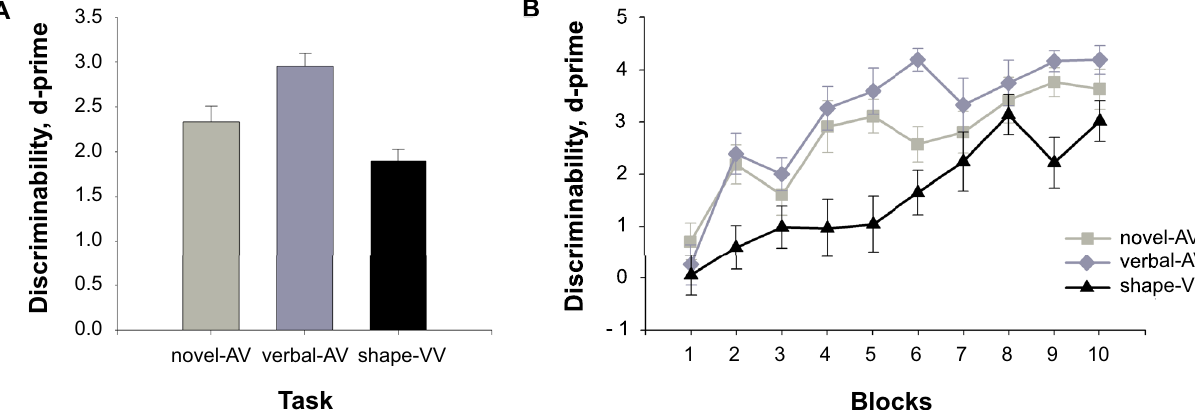
Figure 4. Discriminability measures for associative learning tasks. A . Overall mean discriminability (d-prime) (± SEM) for the novel-sound auditory-visual (novel-AV), the verbal-visual (verbal-AV), and the visual-visual with red shapes (shape-VV) learning tasks. B . Discriminability (d-prime) first 10 blocks of trials on the novel-AV, the verbal-AV, and the shape-VV learning tasks. Each block comprised 5 consecutive trials.